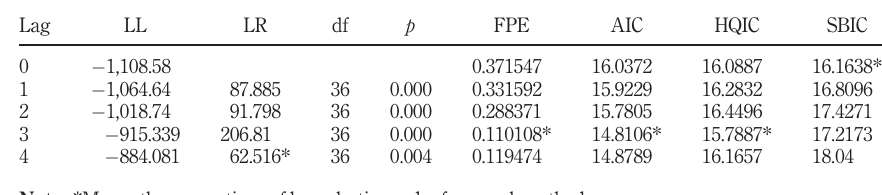
Table IV. The test of lag selection by Lütkepohl (2005)